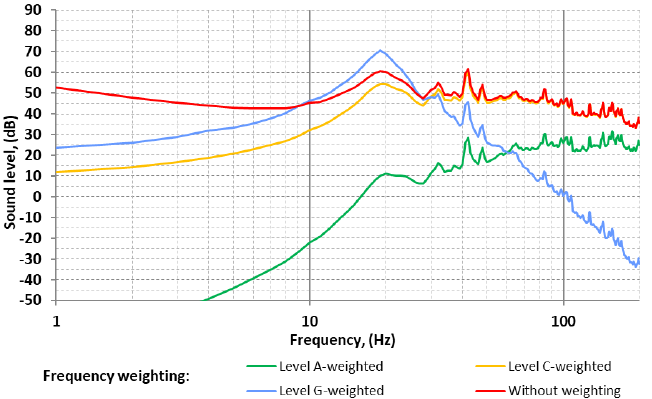
Figure 6. Courses of noise spectra generated by T3 turbine by application of various weighting curves.